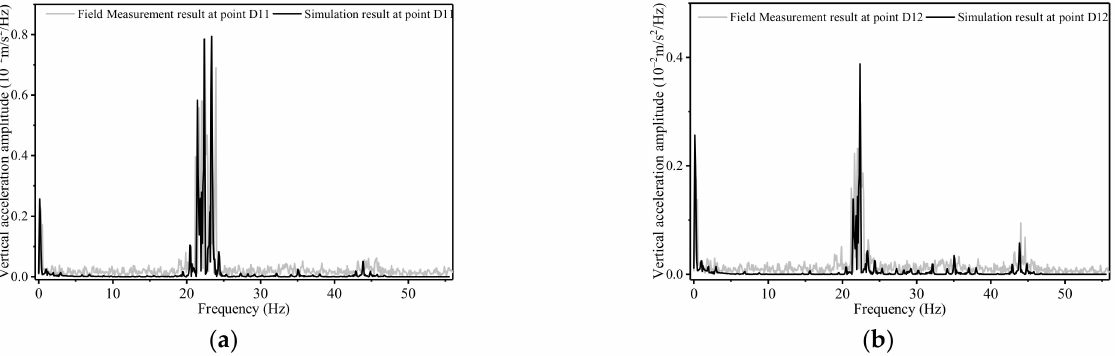
Figure 9. Vertical acceleration amplitude at points D11 and D12. ( a ) Numerical model result; ( b ) Field measurement